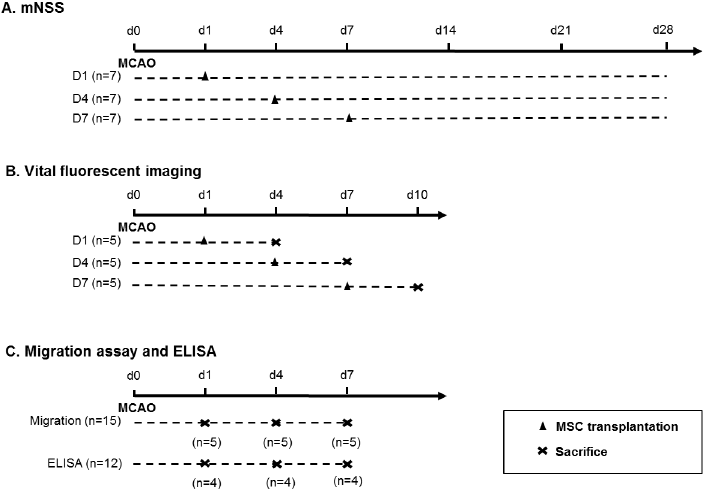
Fig 1. Study design. MSCs were transplanted to the experimental groups at 1, 4, and 7 days after MCAo. Each of these three groups was referred to as the D1, D4, and D7 groups. mNSS indicates modified neurological severity score; MCAo, middle cerebral artery